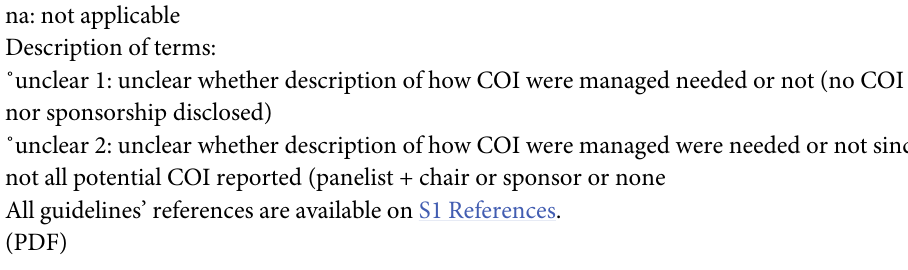
S1 Table. Analysed guidelines. List of